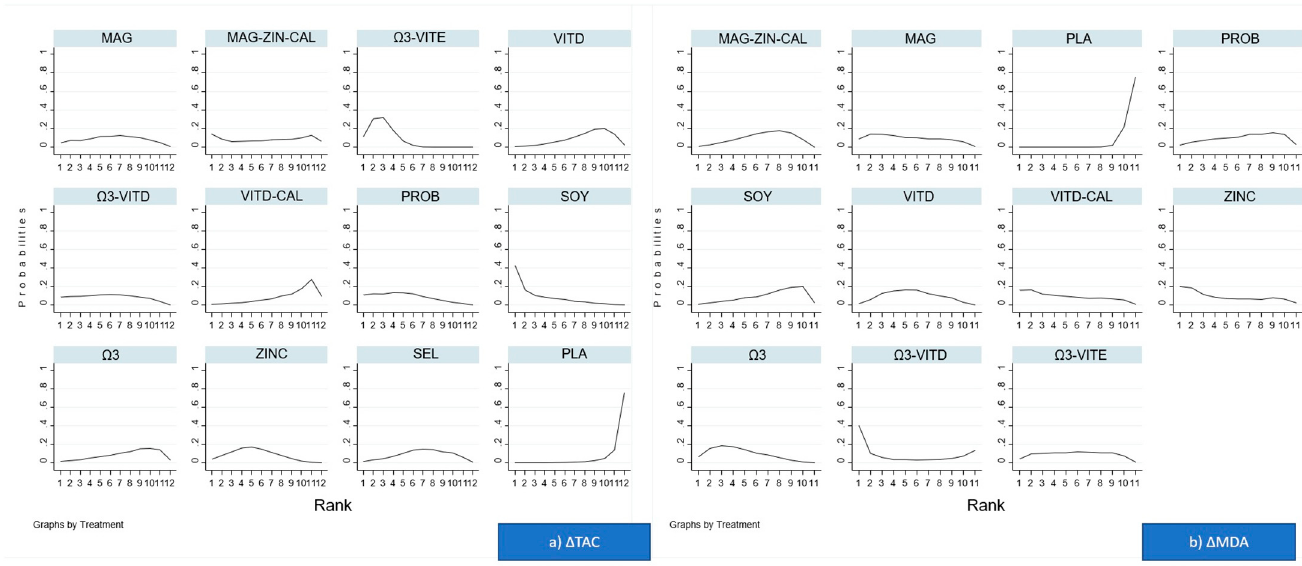
Figure 4. Rankograms for ( a ) ∆ TAC (changes in total antioxidant capacity) and ( b ) ∆ MDA (changes in malondialdehyde) and the surface under the cumulative ranking curve (SUCRA) for each intervention. Horizontal axis shows possible ranks and vertical axis shows probability that an intervention is at each rank.